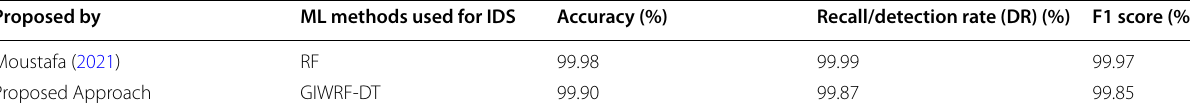
Table 10 Comparison between existing methods and our proposed approach for Network TON_IoT Proposed